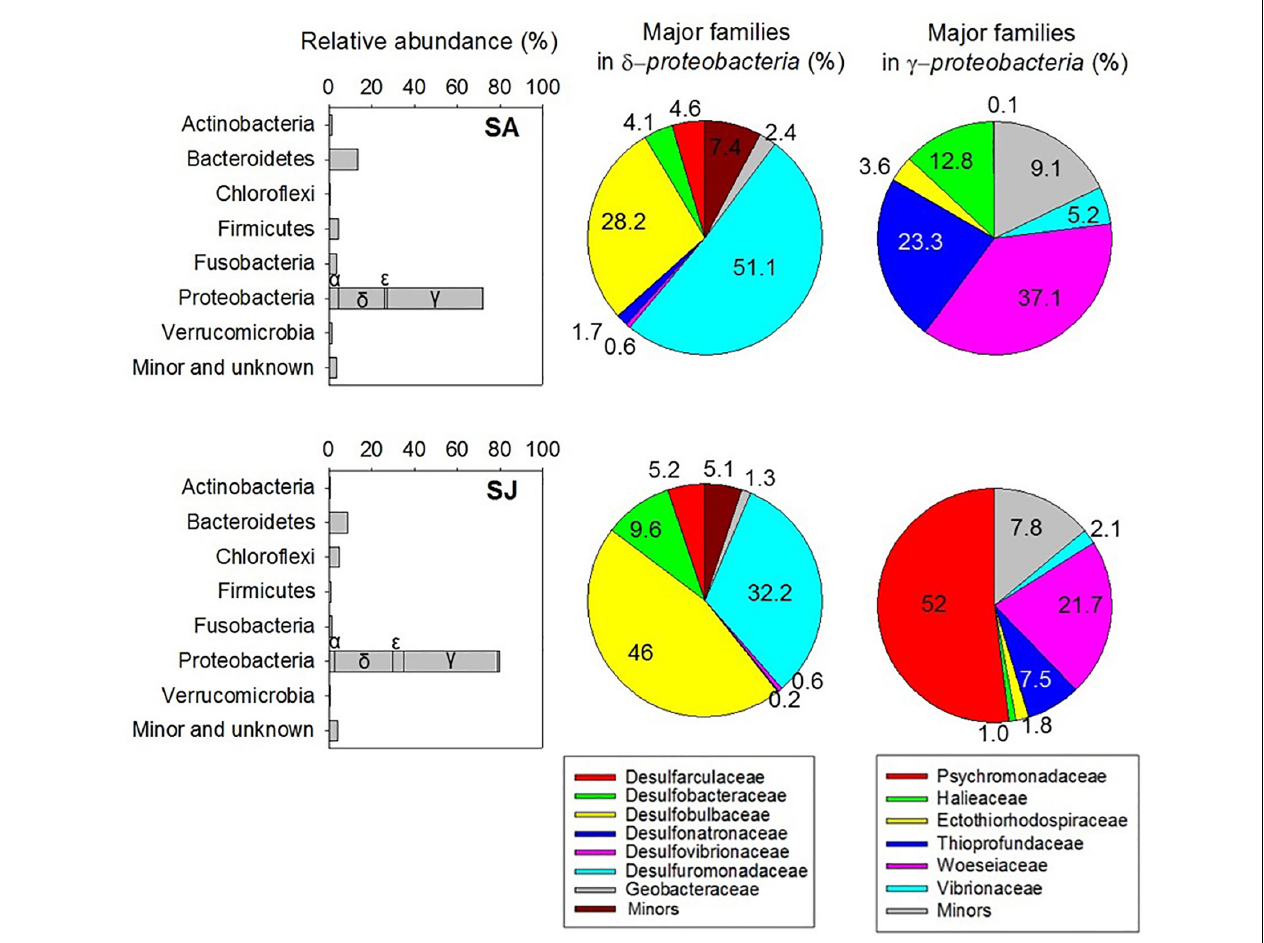
FIGURE 6 | Relative abundance of major bacterial phyla (bar chart) and families in Delta- and Gammaproteobacteria (pie chart) within a depth of 4–8 cm of the sediment inhabited by invasive Spartina anglica (SA) and native Suaeda japonica